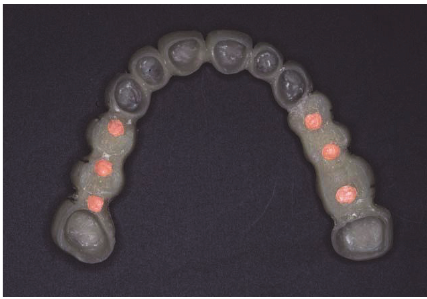
Figure 5: A diagnostic wax-up was made on casts mounted on a semi-individual articulator.